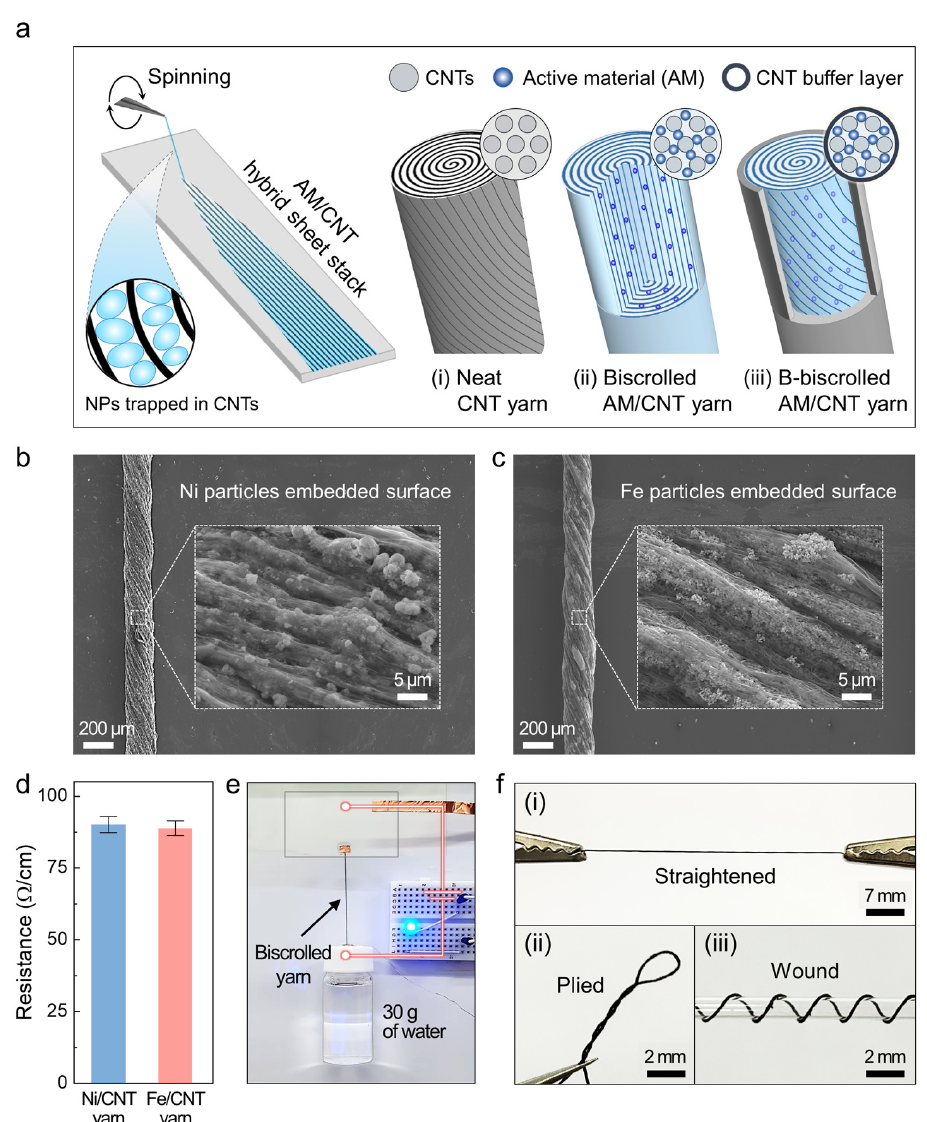
Figure 1. Fabrication of a biscrolled AM/CNT yarn with outer buffer layer. ( a ) Schematic of fabrication of biscrolled AM/CNT yarns. The AM/CNT hybrid sheets were scrolled and wrapped into a neat CNT layer to build a buffered biscrolled AM/CNT yarn (i.e., a b–biscrolled AM/CNT yarn) in which the AM NPs are uniformly distributed within the CNT framework. The SEM images and magnified areas (insets) show the surfaces of ( b ) a 98.5 wt% Ni–embedded cathode yarn